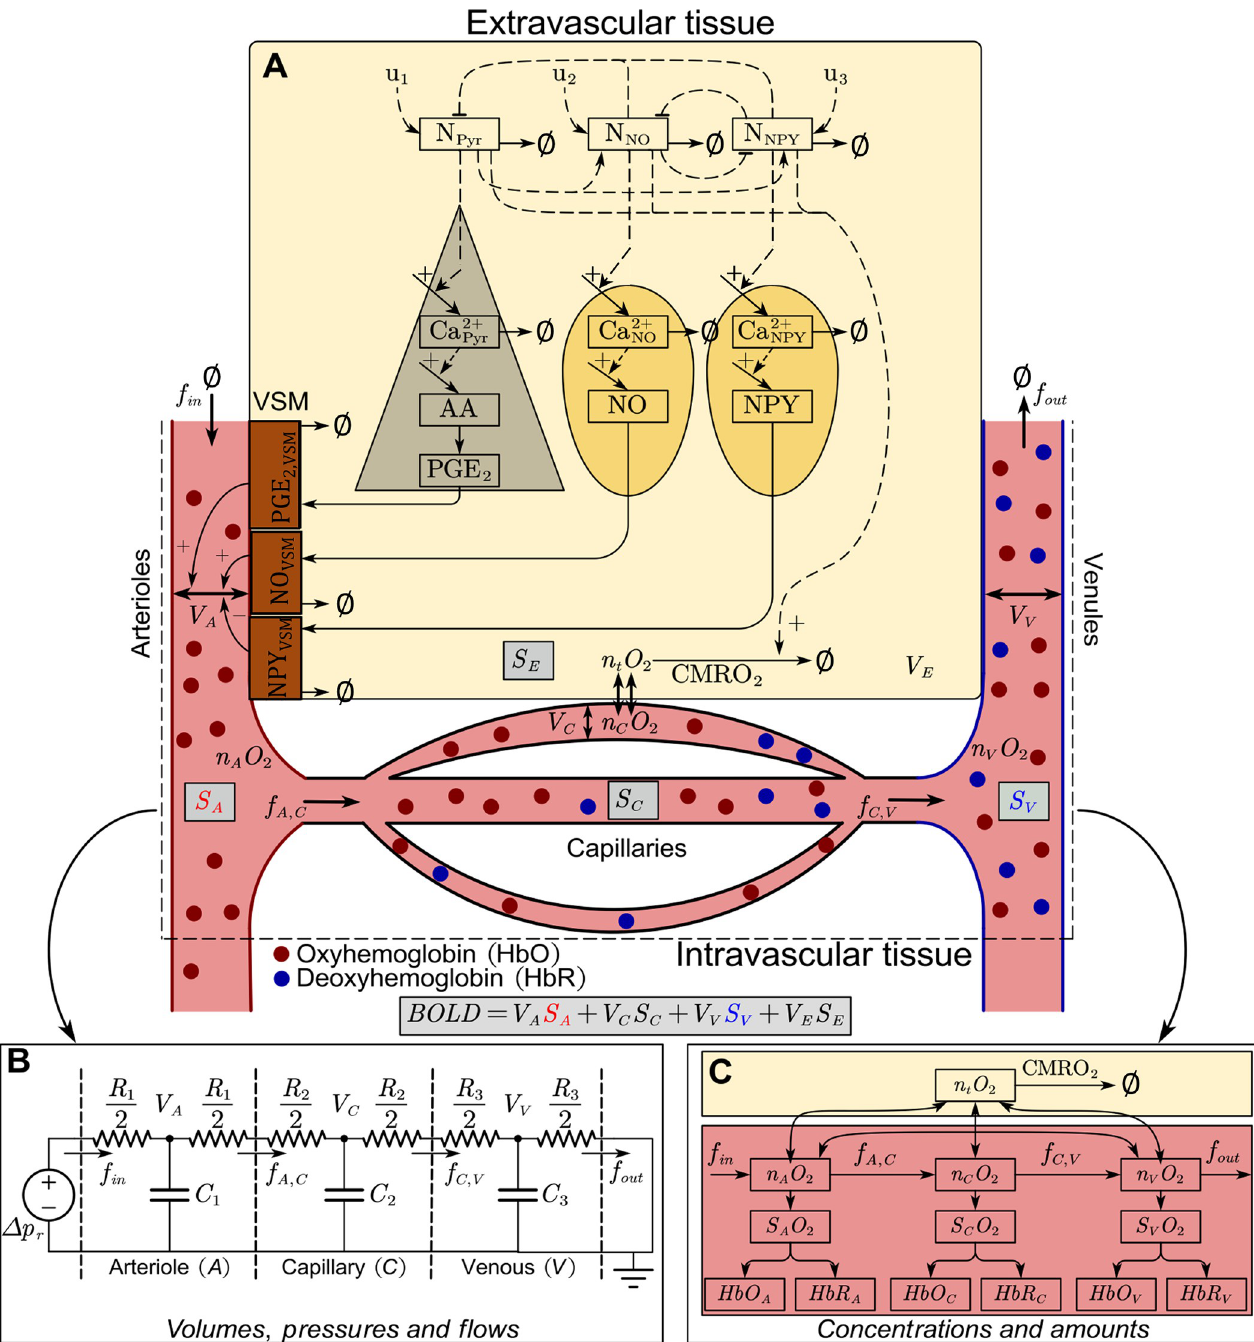
Fig 2. Interaction graph of the model. A: a simplified overview of the model described in [42]. Two distinct types of cells are described: pyramidal neurons (grey triangle, left) and GABAergic interneurons (divided into nitric oxide (N NO )- and neuropeptide Y (N NPY )-expressing neurons; yellow oval shapes, right). These neurons are connected in a simple relationship, with pyramidal neurons (N Pyr ) exciting GABAergic neurons, which in turn inhibit the surrounding cells. Reduction of excited neural activity is illustrated as a flux towards ; , likewise, mass removal from other states is illustrated with a flux towards ; . Activation of a neuron causes an influx of Ca 2+ ions, which is initiated by the electrical stimulation described by u 1 , u 2 , and u 3 for the respective neurons. In pyramidal neurons, Ca 2+ activates phospholipases, which convert phospholipids into arachidonic acid (AA). AA is further metabolized into prostaglandin E2 (PGE 2 ). In NO-expressing interneurons, Ca 2+ activates nitric oxide synthase, which triggers the production and release of nitric oxide (NO). In other subtypes of GABAergic interneurons, vesicle-bound vasoactive peptides such as neuropeptide Y (NPY) are expressed. The release of these peptides is facilitated by Ca 2+ . Vascular smooth muscle (VSM) cells (brown rectangles) enwrap arterioles (left side of the vascular tree) and regulates the arteriolar diameter. PGE 2 promotes arteriolar dilation by activation of the prostaglandin EP 4 receptor located on the VSM. NO diffuses freely over cellular membranes and acts to increase the